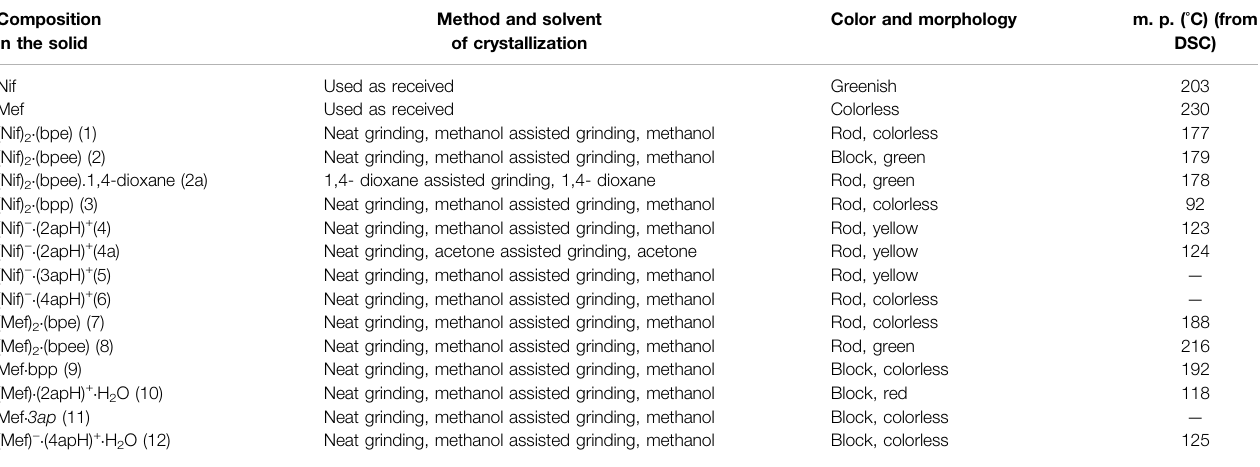
TABLE 1 | Crystallization method used for the synthesis of Nif and Mef based multicomponent solids in the present study and their physical properties. Solids 5 , 6 and 11 could not be isolated as pure phases. Composition in the